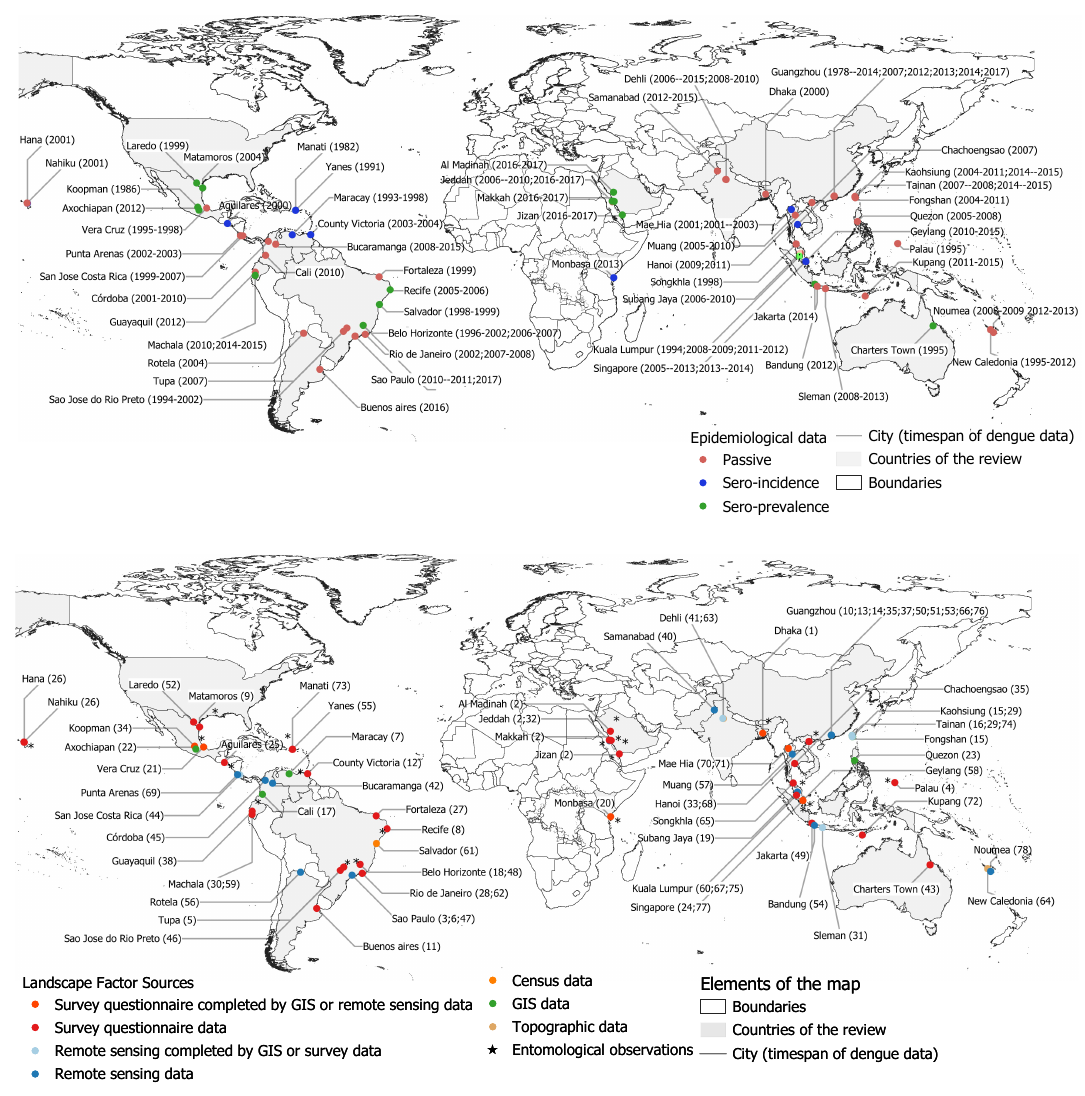
Figure 3. Top: localization and characteristics of the epidemiological data sets of the 78 articles of the review. We indicate the type of sources (serological surveys or passive notification system) and the temporal range associated with the dengue data. Bottom: localization and characteristics of the landscape data sets of the 78 articles of the review. We indicate the type of sources: questionnaire surveys, GIS, Remote sensing data, and the availability of entomological data